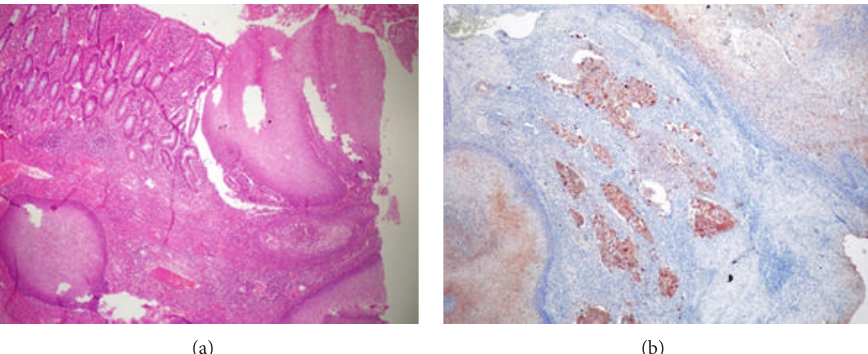
Figure 2: (a) Duodenal mucosa and squamous cells are seen together, stained with H&E, 40-fold magnification. (b) Invasive foci stained with cytokeratin staining, 40-fold